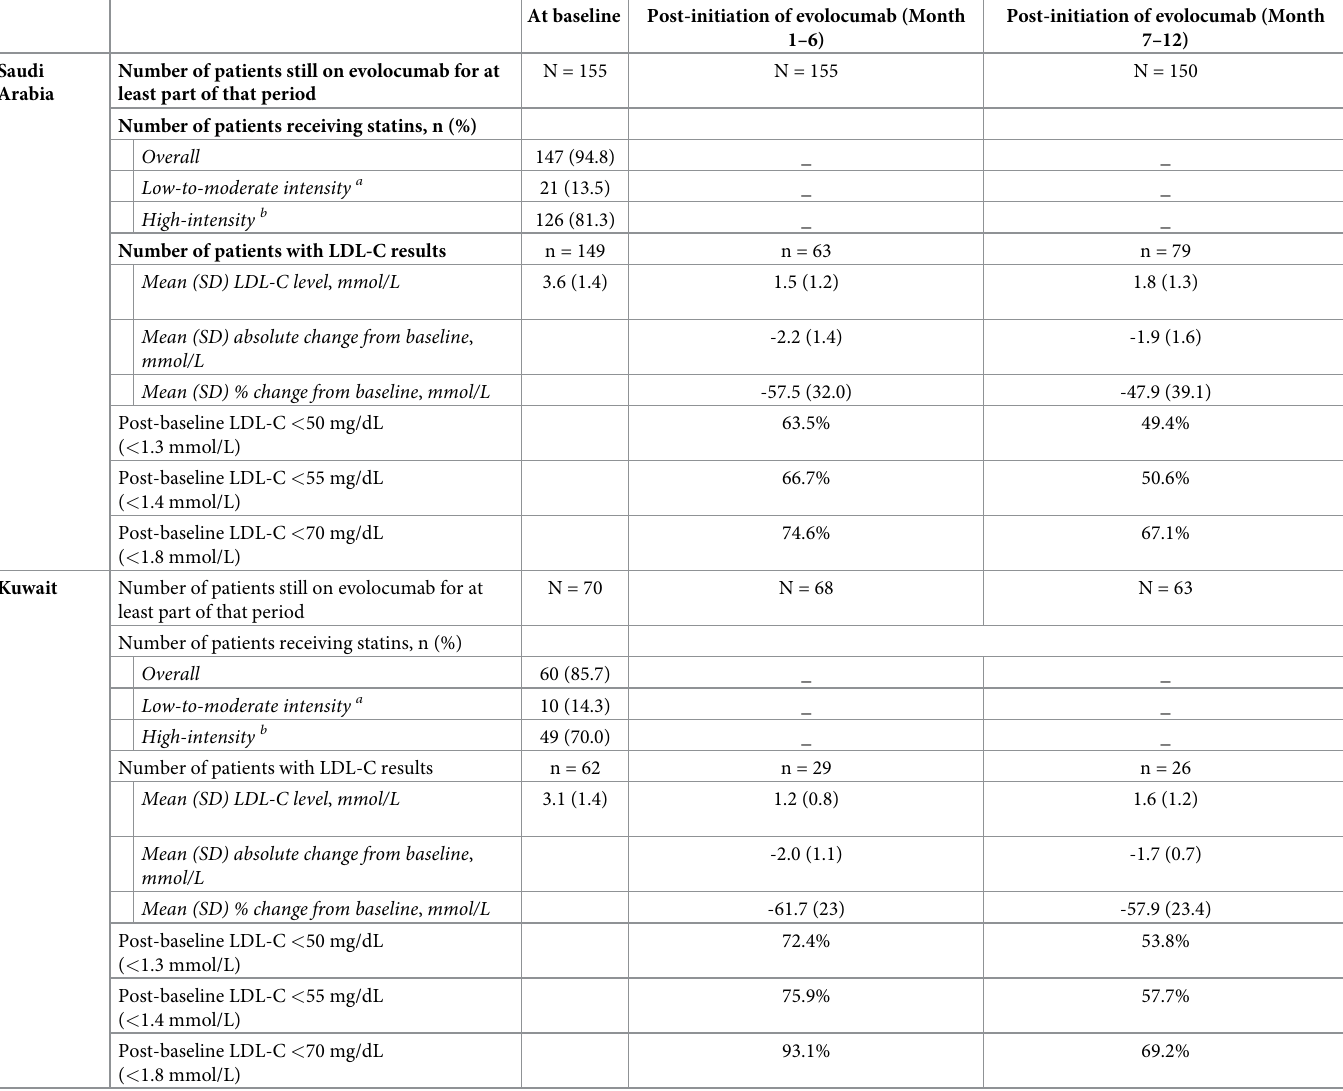
At baseline Post-initiation of evolocumab (Month Post-initiation of evolocumab (Month 1–6) 7–12)